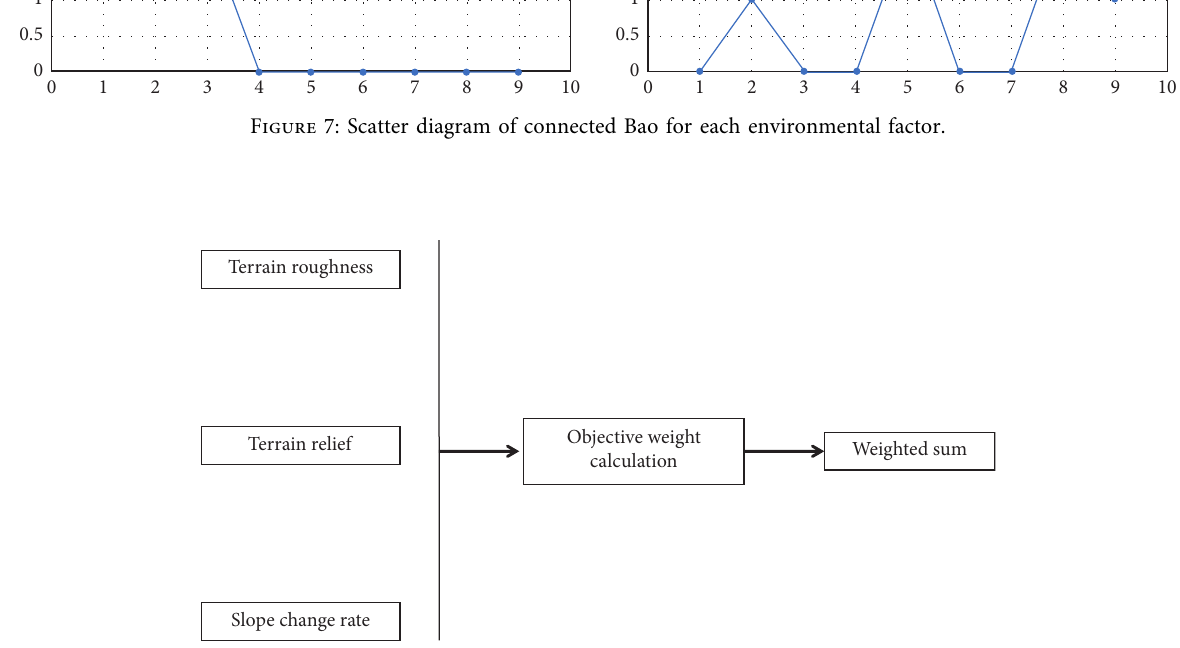
Figure 8: Weighted superposition model of environmental impact factors.